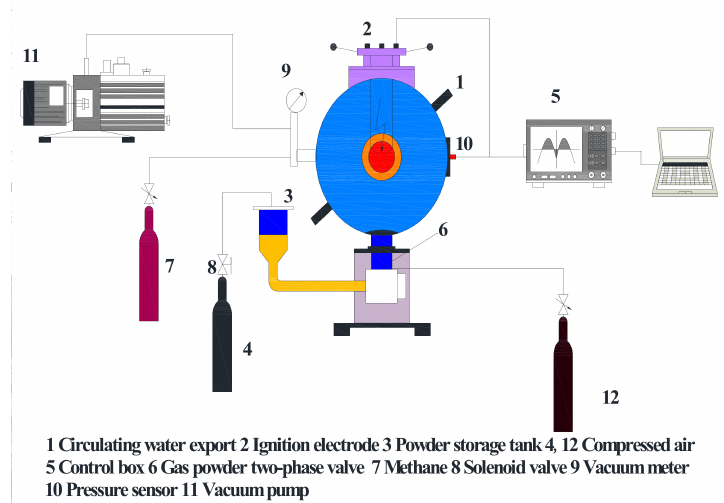
Figure 1. The illustration of 20 L spherical explosion